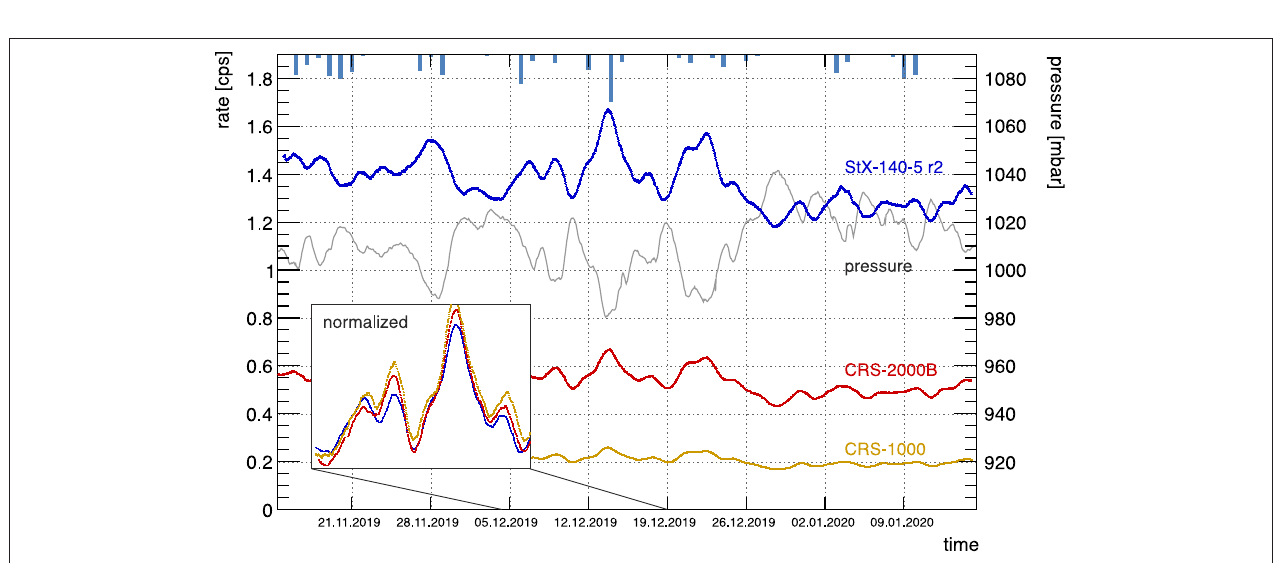
FIGURE 12 | Comparison of different CR probes installed at the Marquardt site (ATB Potsdam). The time series show raw data from the probes, which are tagged using the same color code as in Figure 11 . The integration time of the probes was set to 20 min, however, a moving average of count time series. As a result the count rate errors are in the order of the plotted line width, yet, the averaging leads to an error of the given time scale. Rainfall with a maximum of 8mm is indicated at the top, however the uncorrected rate changes are mainly due to atmospheric pressure changes plotted in gray. The inset shows 2 weeks of data with all probes scaled to each